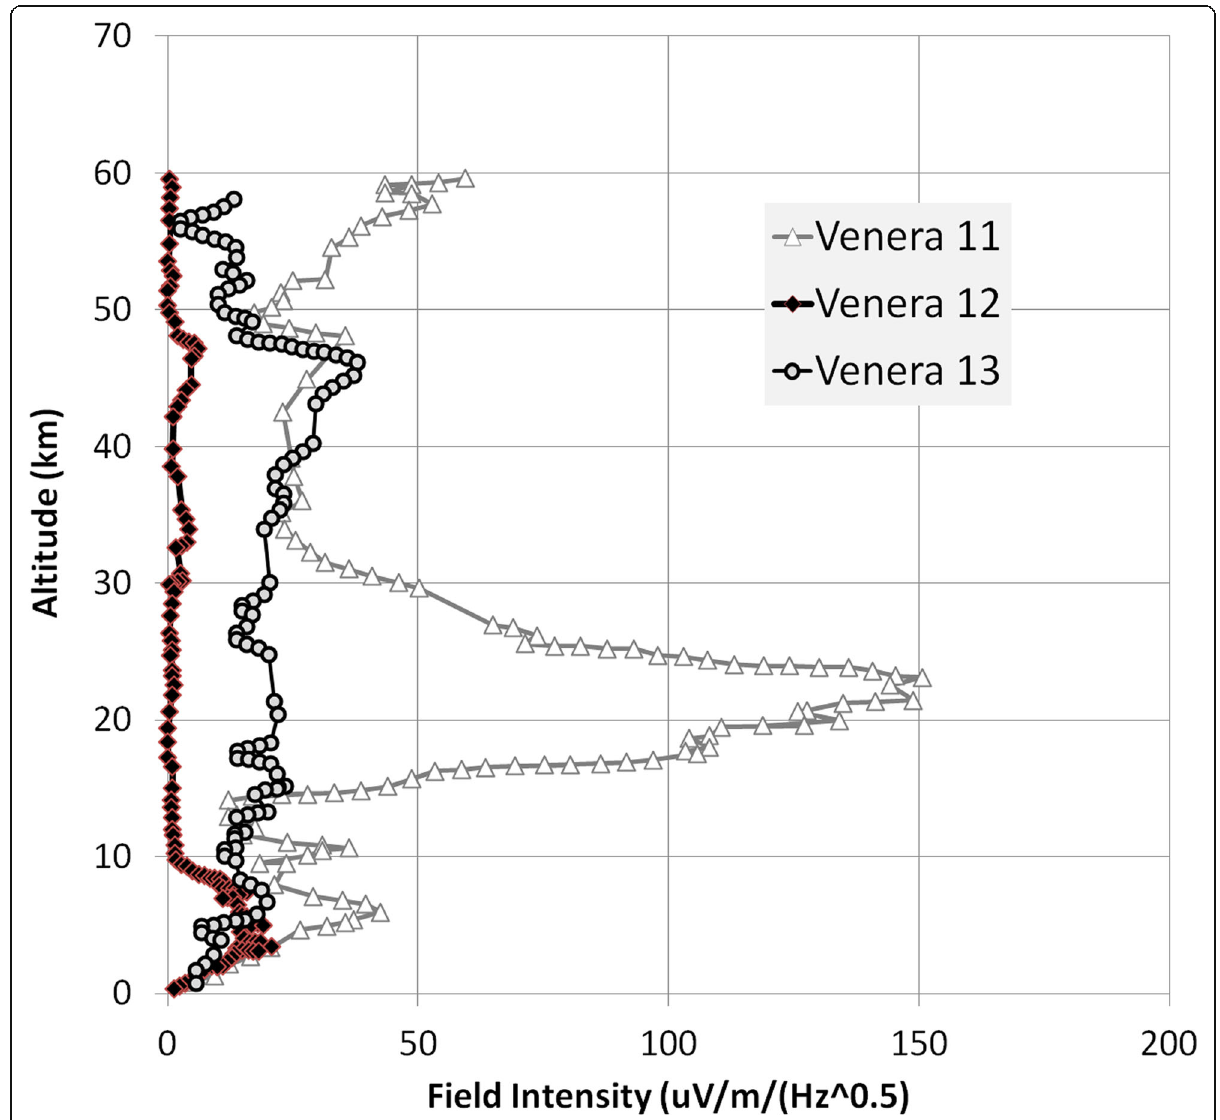
Fig. 7 The electromagnetic field intensity (5 kHz bandwidth centered on 10 kHz) from Veneras 11 – 13 (Ksanfomality et al. 1982,1983) averaged over 20 s intervals, plotted on a common scale which shows the dramatically different character of the Venera 11 profile with the 30 – 15 km altitude range (about 20% of the descent duration) having several times higher intensity than the rest. Previous presentations have tended